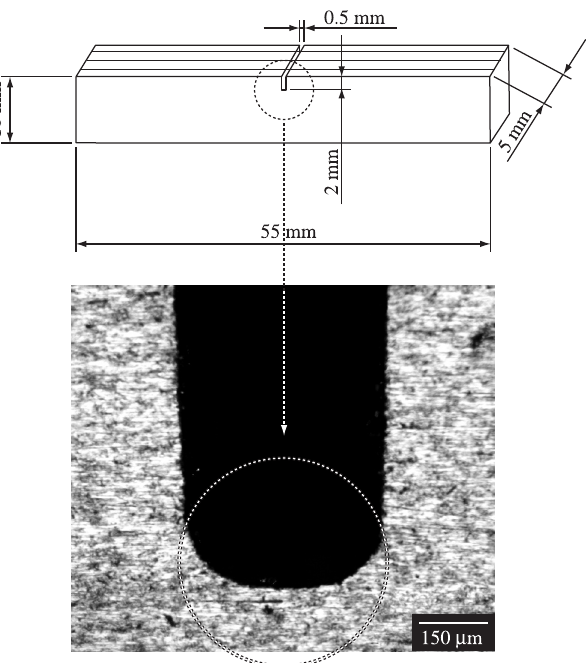
Figure 2. Three-point-bend Charpy impact test piece geometry according to the ASTM D5045 standard 17 (dimensions in mm). The 0.25 mm notch-root radius machined in a TiGr specimen illustrates the good practices adopted in this